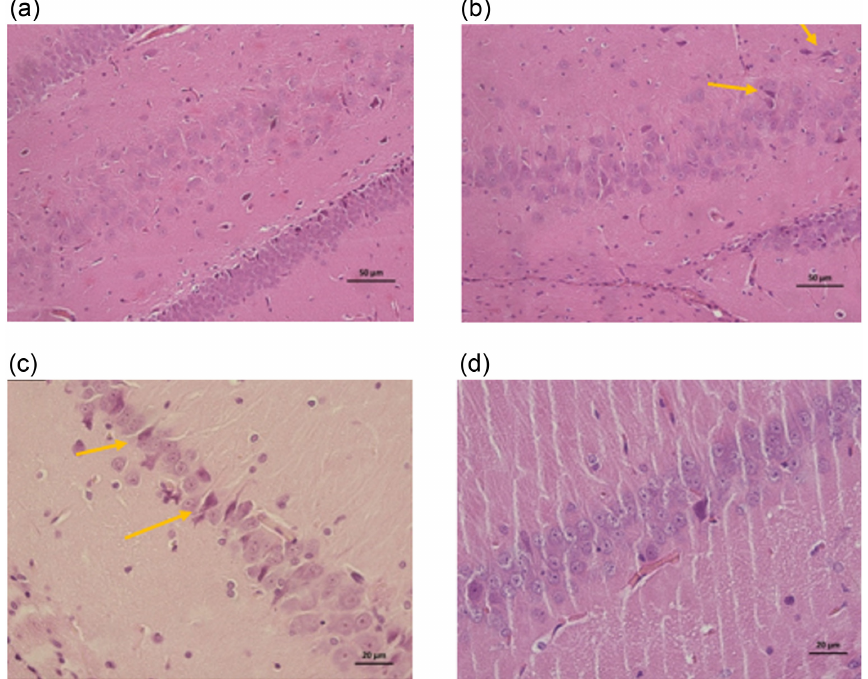
Figure 3. a-d. Histopathologic examination samples of hippocampus of healthy group (a), control group (b), risperidone (c), and apomorphine (d) groups. In healthy group: significantly lower number of degenerated neurons compared to the group receiving risperidone and saline (1-2 pieces). In saline-injected control group: there are very few (2-3) degenerated neurons. In risperidone group: the number of degenerated neurons is much higher than other groups. In apomorphine group: significantly, there are few degenerated